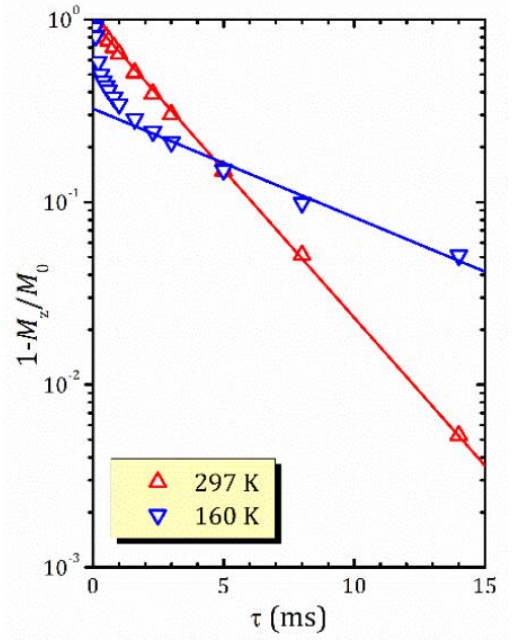
Figure 8. 1 H magnetization recovery curves for the α -form of HCa 2 Nb 3 O 10 · y H 2 O at 297 and 167 K with the exponential fit (solid lines); for 167 K the line corresponds to the slow component